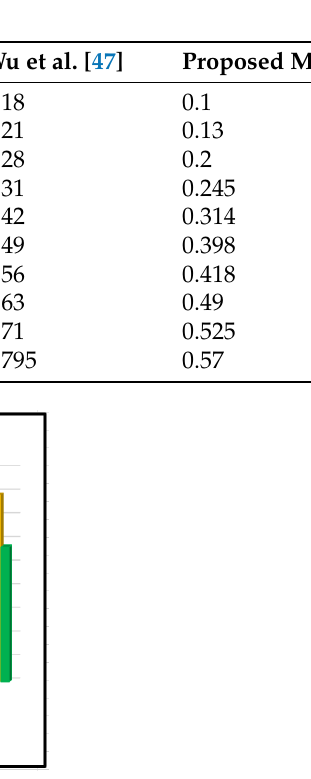
Table 3. Execution time of key generation centre (KGC).